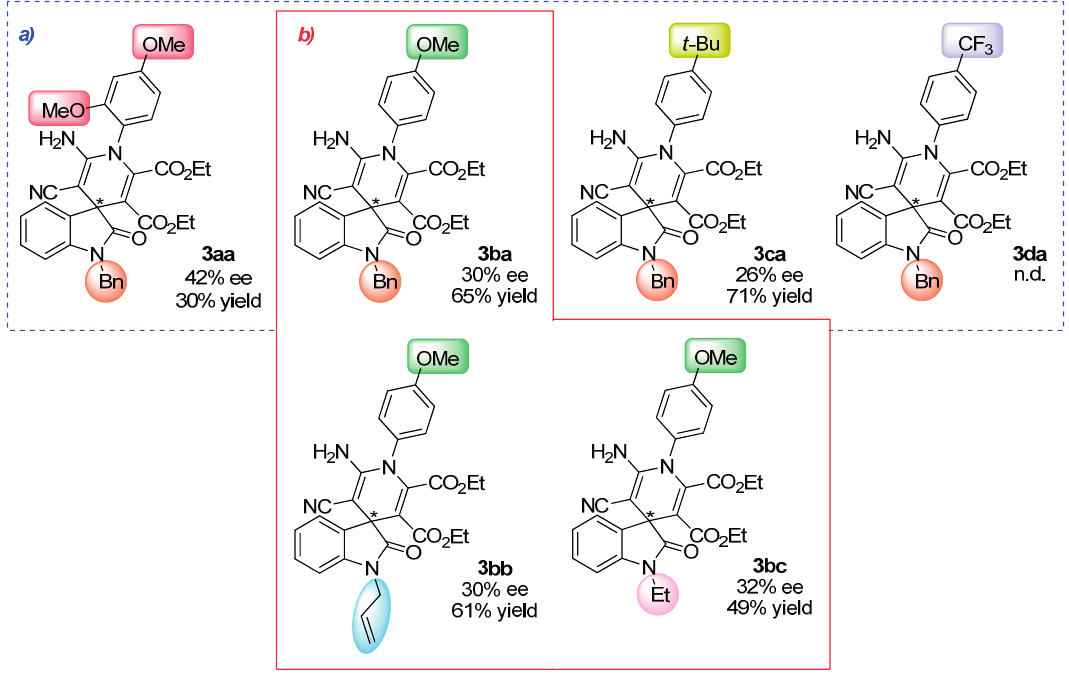
Figure 4. Summary of the comparative studies of ( a ) differently-substituted enamine 1 and ( b ) differently protected isatylidene malononitrile 2 . Table 2. Additional screening of the